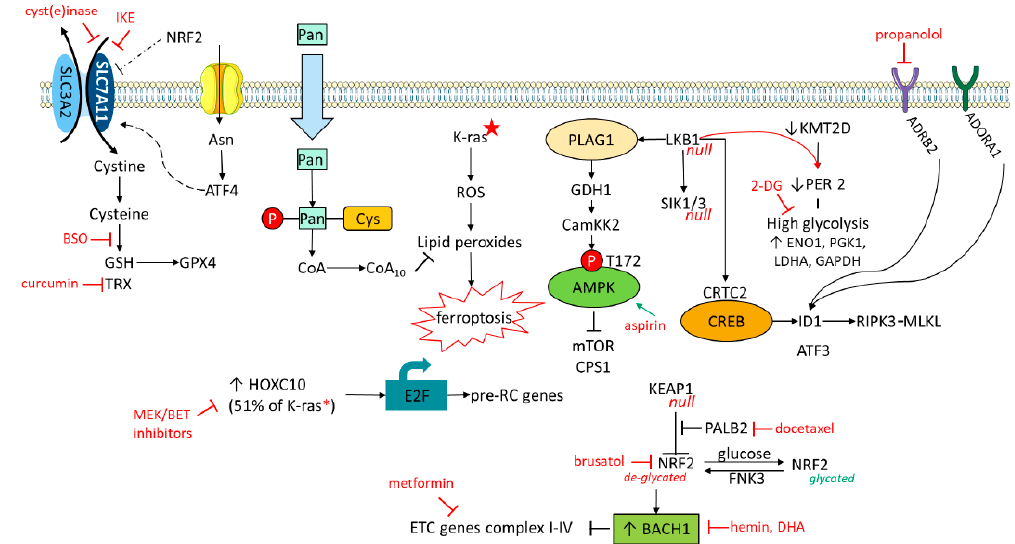
Figure 4. K-ras transcription regulation roadmap. Mutant K-ras signaling induces increased production of reactive oxygen species (ROS) that is counterbalanced by thioredoxin (TRX) and glutathione (GSH) synthesis. GSH leads to the formation of the lipid peroxide-detoxifying enzyme glutathione peroxidase 4 (GPX4). Targeting cystine input with an antiporter xCT (SLC7A11) inhibitor, imidazole ketone erastin (IKE), or cotreatment with an inhibitor of GSH synthesis, buthionine sulfoximine (BSO), induces lipid oxidation reducing cell viability. Coenzyme A (CoA) is produced also by cysteine via the pantothenate (Pant) pathway. CoA and its derivative coenzyme Q10 (CoQ10) cooperate by inhibiting accumulation of lipid ROS (ferroptosis). In vitro cyst(e)inase treatment reduces cell viability in multiple tumor models. Co-mutations and / or loss of LKB1 and loss of salt-inducible kinase 1 and 3 (SIK1 / 3) activate CRTC2 that, with CREB, could signal via ID1 to RIPK3-MLKL (see also Figure 3). CREB is activatable by adenosine A1 receptor (ADORA1) and ADRB2. It is possible that loss of LKB1 with inactivation of AMP-activated protein kinase (AMPK) can downregulate Period (Per), a circadian gene, that is also down regulated when the histone methyltransferase KMT2D is diminished (by mutations occurring often in lung cancer. Loss of KMT2D and Per lead to increased expression of numerous glycolytic genes (ENO1, PGK1, LDHA1, GAPDH and others). Co-treatment up-regulation of genes is involved in the glycolysis pathway. Also, when LKB1 is impaired, pleomorphic adenoma gene 1 (PLAG1) increases glutamate dehydrogenase 1 (GDH1), which leads to increased calcium calmodulin-dependent protein kinase kinase (CamKK2) with AMPK T172 phosphorylation impinging on mTOR and CPS1 (see the text). Aspirin can restore AMPK function. KEAP mutations or loss of function are closely related to NRF2 overproduction. PALB2 is a negative regulator of KEAP function. Docetaxel was associated with better progression free survival, overall survival and response rate in metastatic NSCLC patients with high PALB2 mRNA (see text). De-glycation of NRF2 by fructosamine-3-kinase (FN3K) is pivotal for NRF2 function. Brusatol is a NRF2 inhibitor. BTC and CNC homology 1 (BACH1) is induced by alterations in the KEAP- NRF2 axis. BACH1, a heme-binding transcription factor, negatively regulates transcription of electron transport chain (ETC) genes. Combination of hemin (we posit that also dihidroartemisin (DHA)) with metformin is e ff ective in cancer cell lines. The homeobox protein HOXC10 is overexpressed in 51% of K-ras mutant NSCLC); BET plus MEK inhibitors suppress pre-replication, triggering stalled replication and DNA damage. Proviso: The figure construction is based on robust findings, some of them recently described, and thereby cited in the legend. Since there are multiple biological routes involved, the pretension of the figure is to provide a glimpse at the approximate actual knowledge that could serve for developing biomarkers and customizing therapy in K-ras mutant